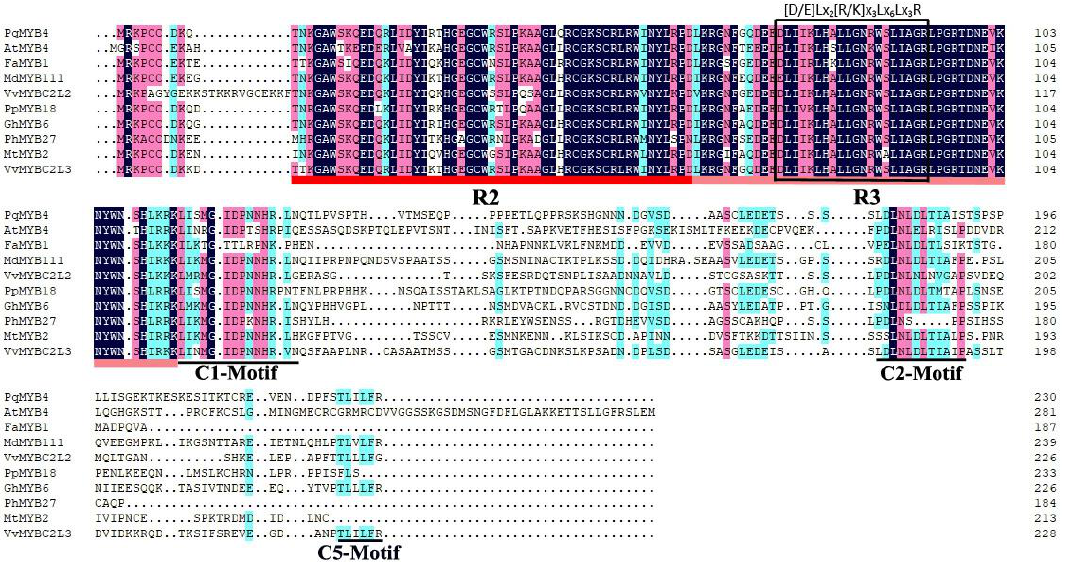
Figure 4. Alignment of PqMYB4 deduced amino acid sequence with similar proteins from other species. Alignment was conducted using DNAMAN Version 8. The R2 and R3 MYB domains shown refer to two repeats of the MYB DNA-binding domain of MYB proteins. The black box shows the